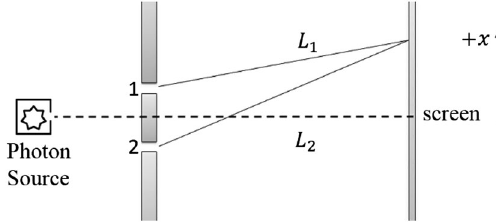
FIG. 6. DSE setup with a vertical polarizer placed after slit